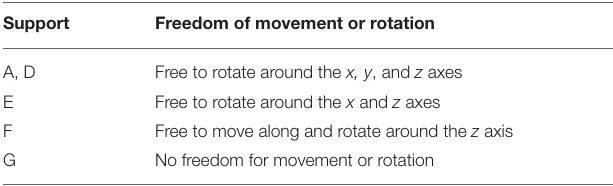
TABLE 4 | Complementary details of the supports of the structural system displayed in Figure 10A